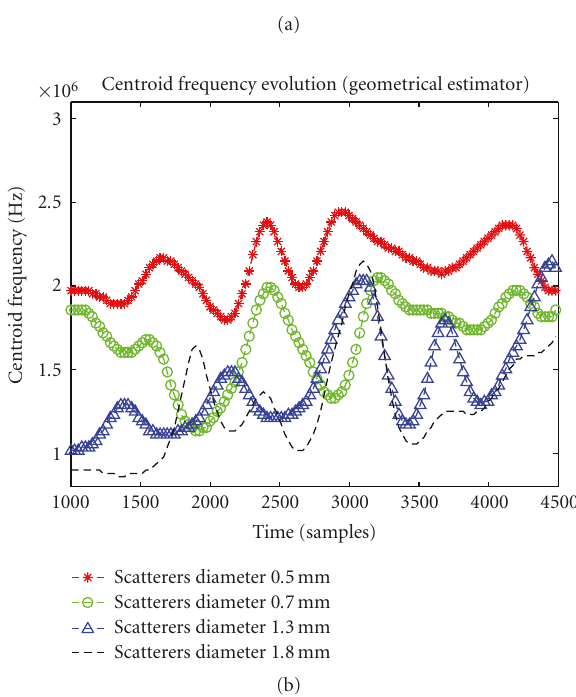
Figure 9: Centroid frequency evolution with depth (time of flight). Comparison between the same parameter computed with conventional estimator (a) and geometrical estimators